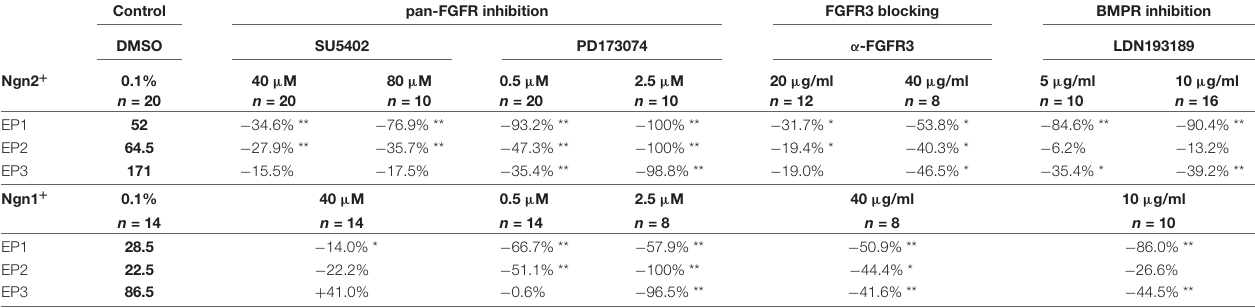
TABLE 2 | Relative changes of neuroblast numbers in the epibranchial placodes of 9–14 somite mouse embryos cultured for 24 h.